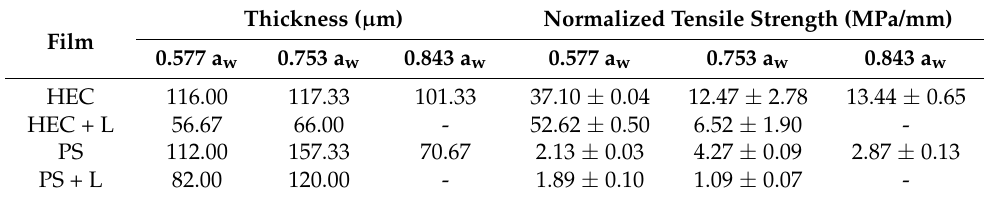
Table 1. Thickness and normalized tensile strength results for the analyzed films, exposed to 0.577, 0.753 and 0.843 a w